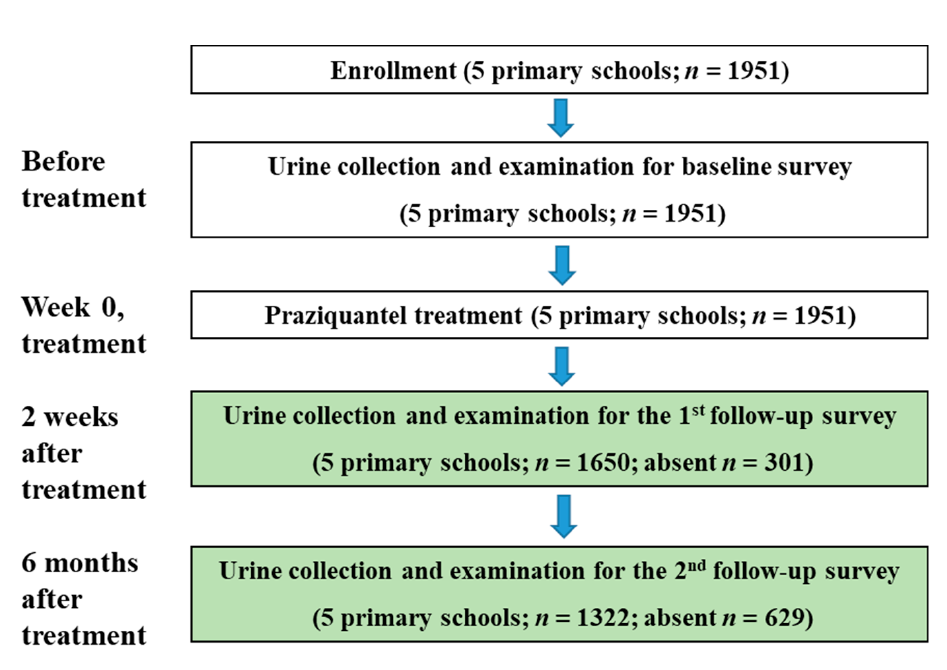
Figure 2. Flow chart of the longitudinal cohort study.